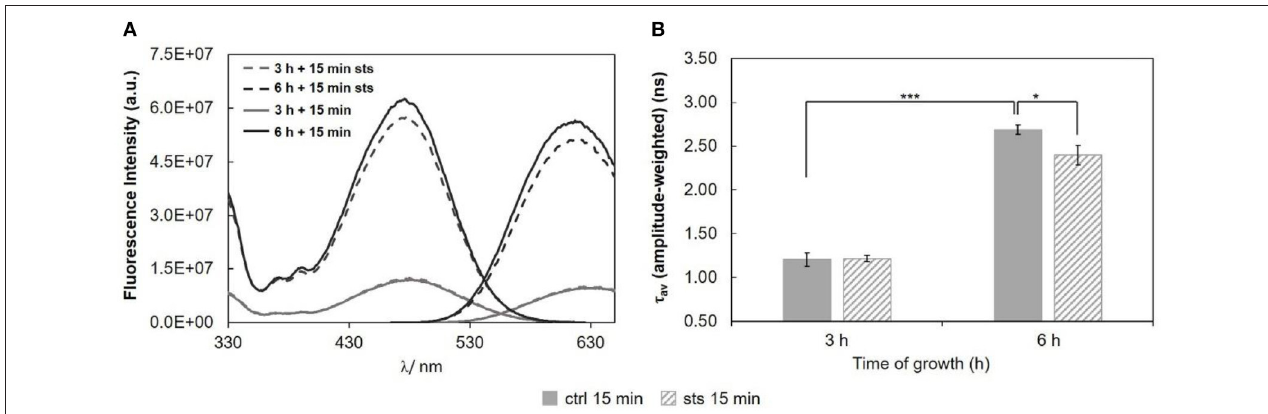
FIGURE 8 | Di-4-ANEPPS fluorescence properties in N. crassa cells, at 30 ◦ C, (A) fluorescence excitation ( λ em = 635nm) and emission spectra ( λ exc = 450nm), (B) amplitude-weighted mean fluorescence lifetime of di-4-ANEPPS. The results present the mean ± S.D. of at least three independent experiments, n ≥ 3. * p < 0.05, *** p <